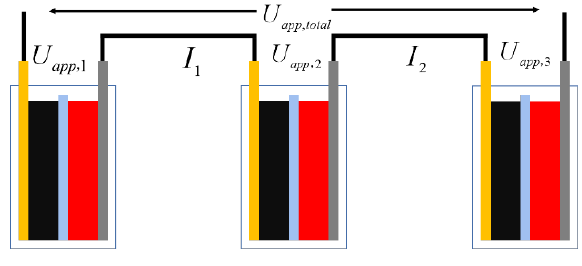
Figure 3. Module series